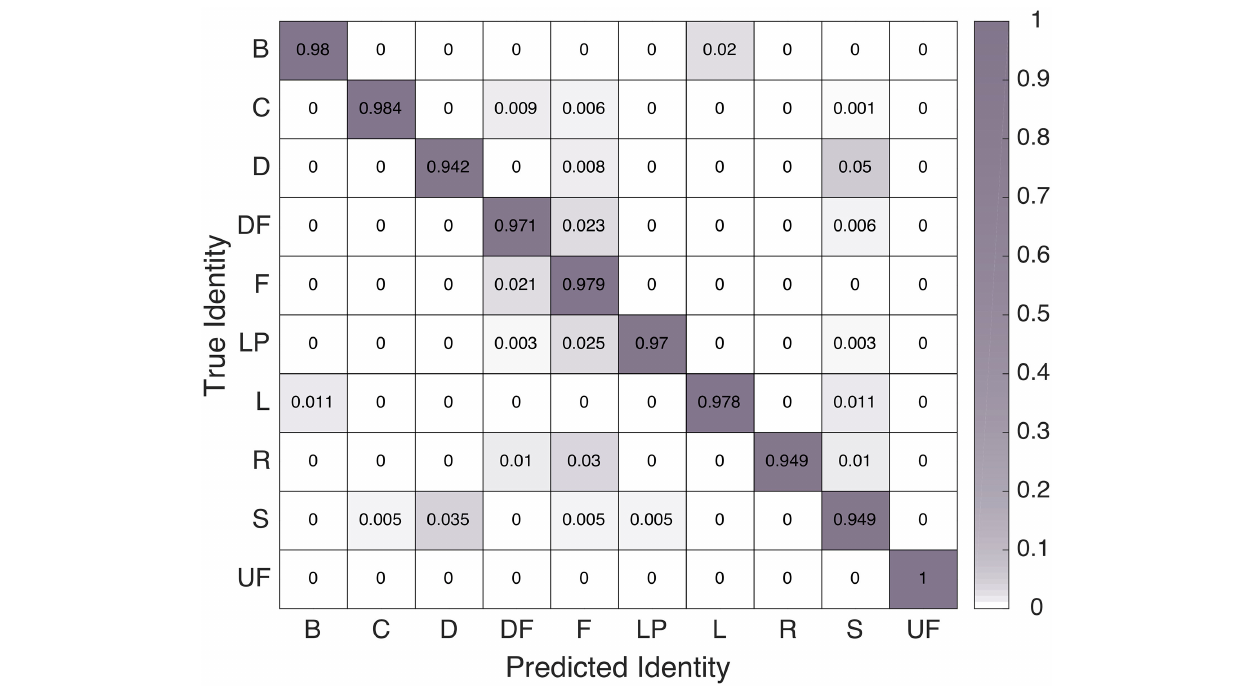
FIGURE 3 | Confusion matrix of linear SVM classifier performance on the training dataset.